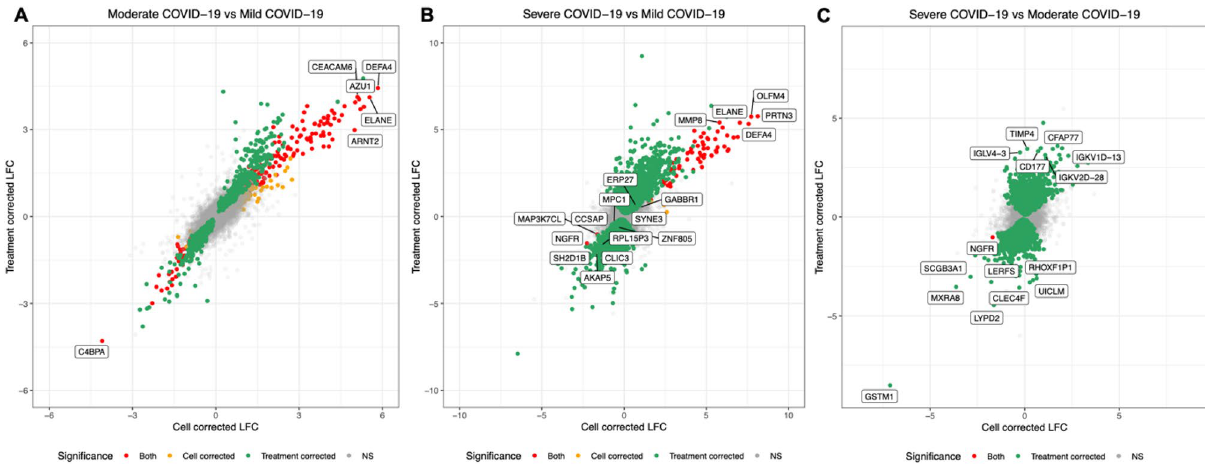
Figure 2. Cross plots showing the log 2 fold change (LFC) values of genes for pairwise comparisons between three severity groups ( A : moderate vs. mild; B : severe vs. mild; C : severe vs. moderate). The plots show how LFC values differ according to whether immune cell proportions (x-axis) or immunomodulatory treatments (y-axis) were included in the models. Red points are genes that were SDE in both models, whilst orange and green points are genes SDE in the cell correction and treatment correction models, respectively. NS not